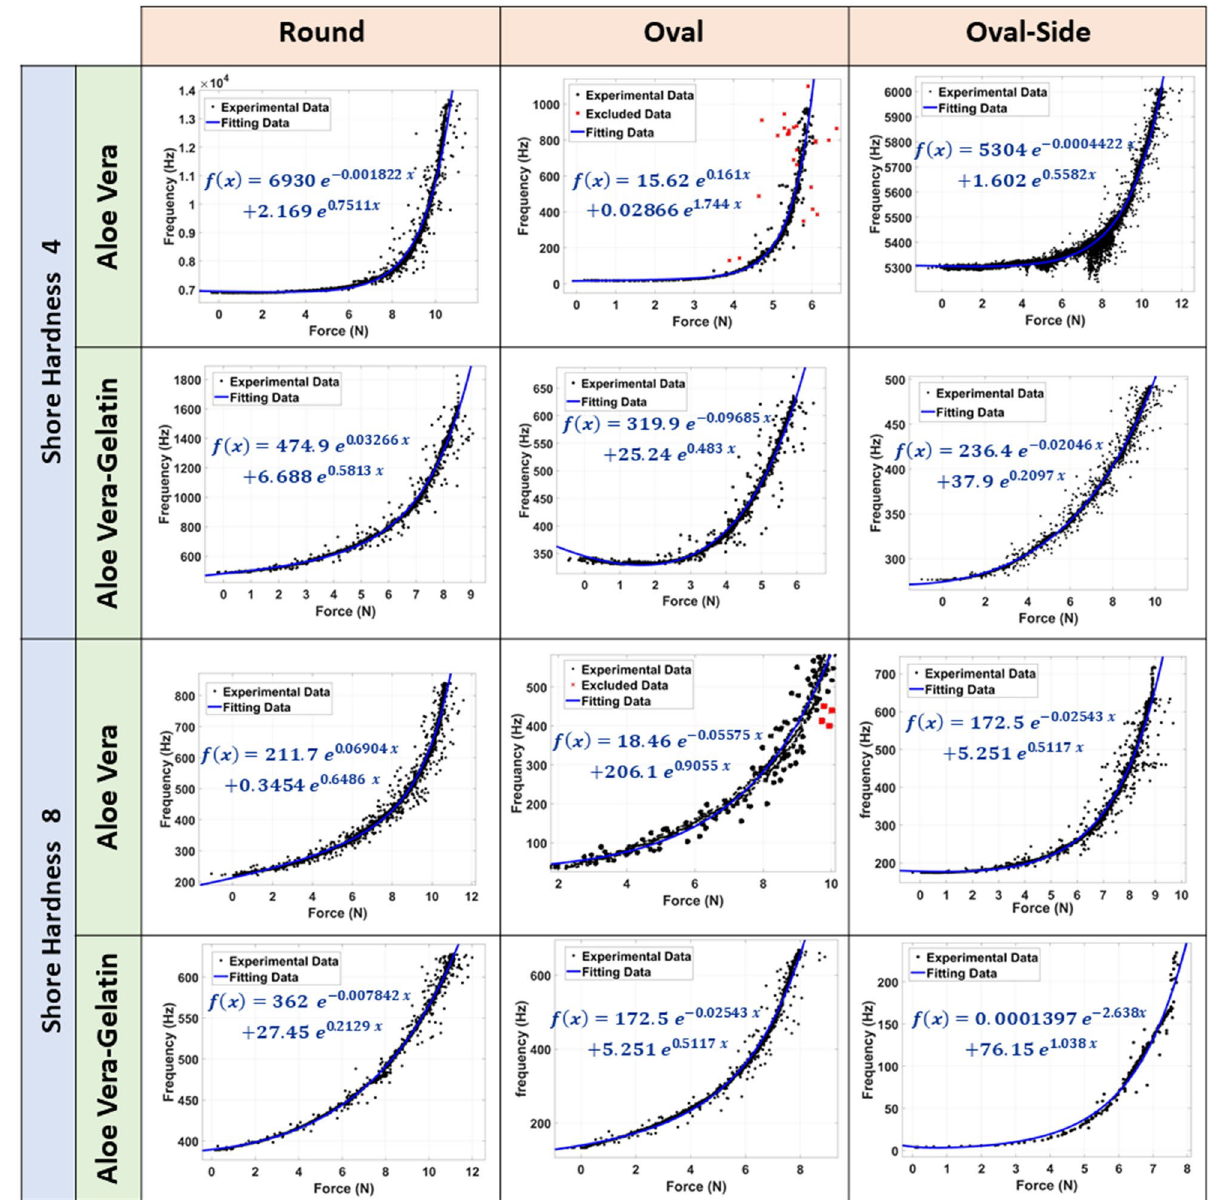
these tissues is investigated in different channel geometries and different shore hardness silicone material. The fitting results are added to each graph and the fitting equation that is an exponential function is represented on each